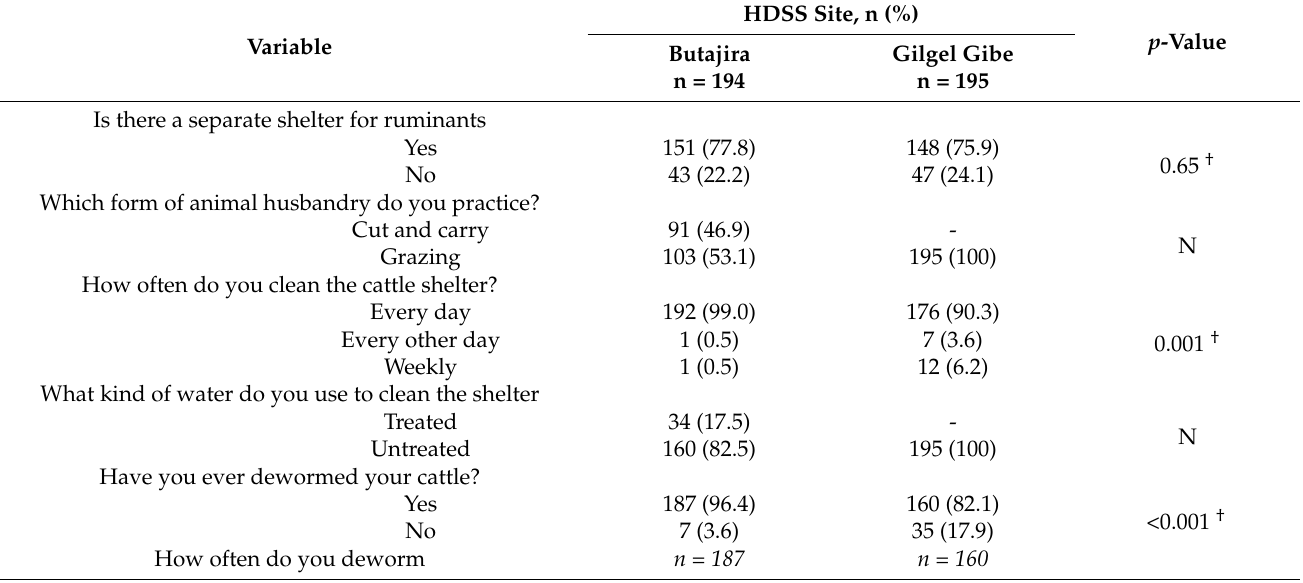
Table 5. Livestock husbandry practices of households in a study of fasciolosis in Butajira and Gilgel Gibe HDSS sites,